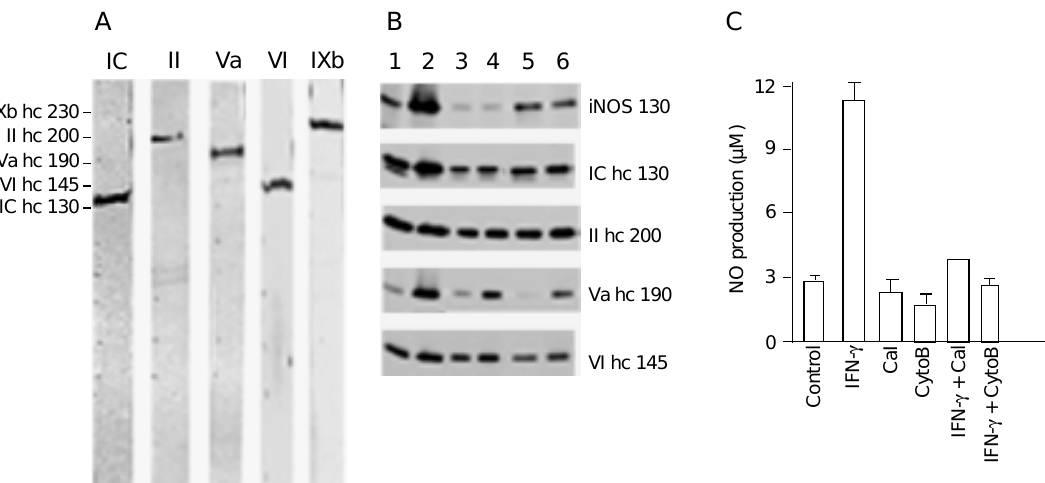
Figure 1 - Effect of IFN- g , calcium ionophore (CaI) and cytochalasin B (CytoB) on nitric oxide (NO) production, and on inducible NO synthase (iNOS) and myosin expression. J774 macrophages (5 x 10 2 cells/ml) were cultured with IFN- g , alone or with CytoB or with A23187 calcium ionophore. NO production was measured by the method of Greiss in macrophage supernatants. iNOS and myosin expression was determined from cell lysates by Western blotting. A , Western blot of J774 lysates to determine the presence of myosins IC, II, Va, VI and IXb. Antibodies specifically recognized myosin heavy chains (hc). B , Western blot of treated macrophage lysates stained with monoclonal anti- iNOS and anti-myosin II antibodies, and with affinity-purified rabbit anti-myosin I, Va and VI. Lane 1 represents control (medium only) cell lysates. Lanes 2-6 represent lysates from cells treated with IFN- g , CaI, CytoB, IFN- g + CaI and IFN- g + CytoB. iNOS 130: Region of 130 kDa recognized by specific monoclonal antibody, IC hc 130: 130-kDa heavy chain of myosin IC, II hc 200: 200-kDa heavy chain of myosin II, Va hc 190: 190-kDa heavy chain of myosin Va, VI hc 145: 145-kDa heavy chain of myosin VI, and IXb hc 230: 230-kDa heavy chain of myosin IXb. C , NO production by treated macrophages. Three samples from each treatment were processed in duplicate (N = 6).